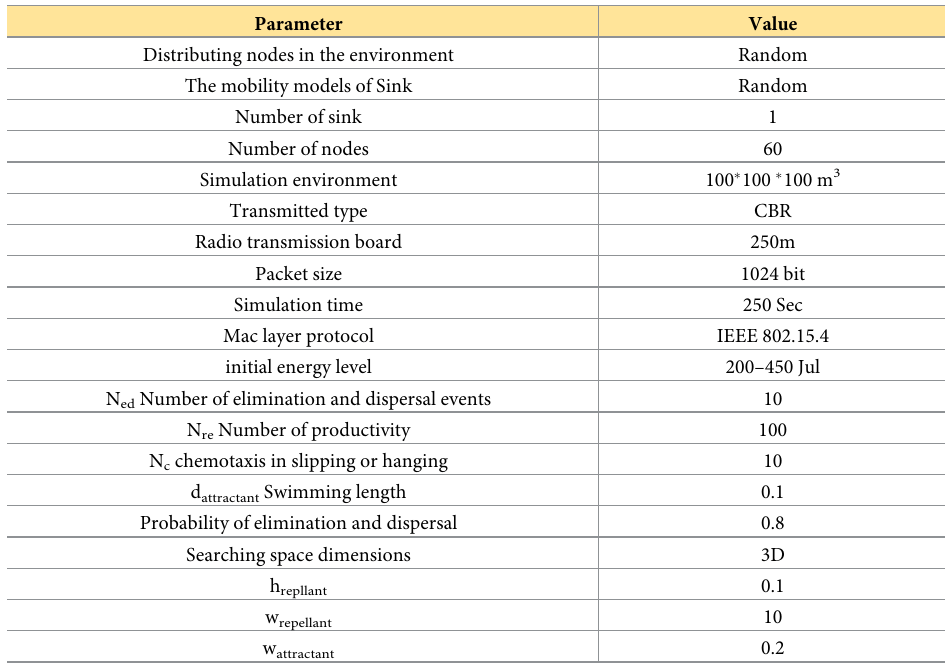
Table 2. Simulation parameters